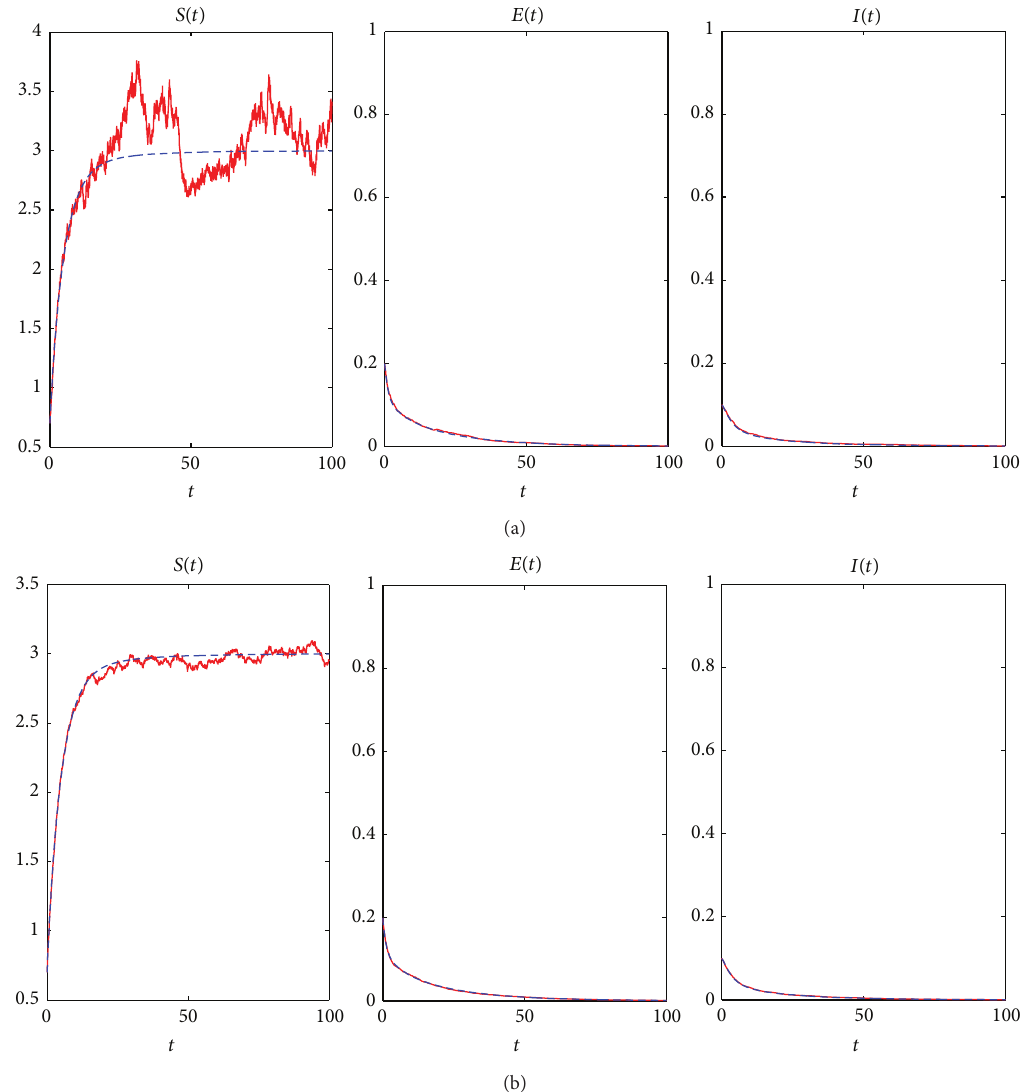
Figure 1: 𝑆(0) = 0.7 , 𝐸(0) = 0.2 , 𝐼(0) = 0.1 , Λ = 0.6 , 𝛽 = 0.4 , 𝜇 = 0.2 , 𝛿 = 0.1 , 𝛾 = 0.2 , 𝜖 = 0.15 , 𝑑 = 0.1 , and Δ𝑡 = 0.002 . Group (a) 𝜎 1 = 0.04 , = 0.03 , and 𝜎 = 0.03 . Group (b) 𝜎 𝜎 2 3